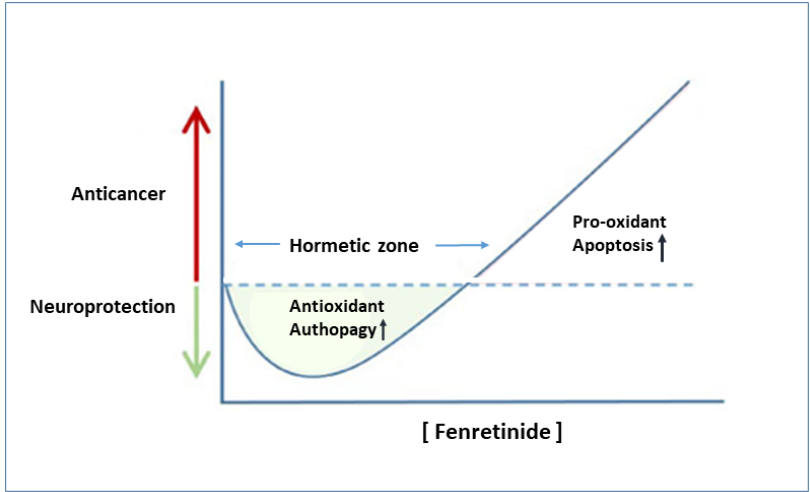
Figure 3. Hormetic dose response of fenretinide.